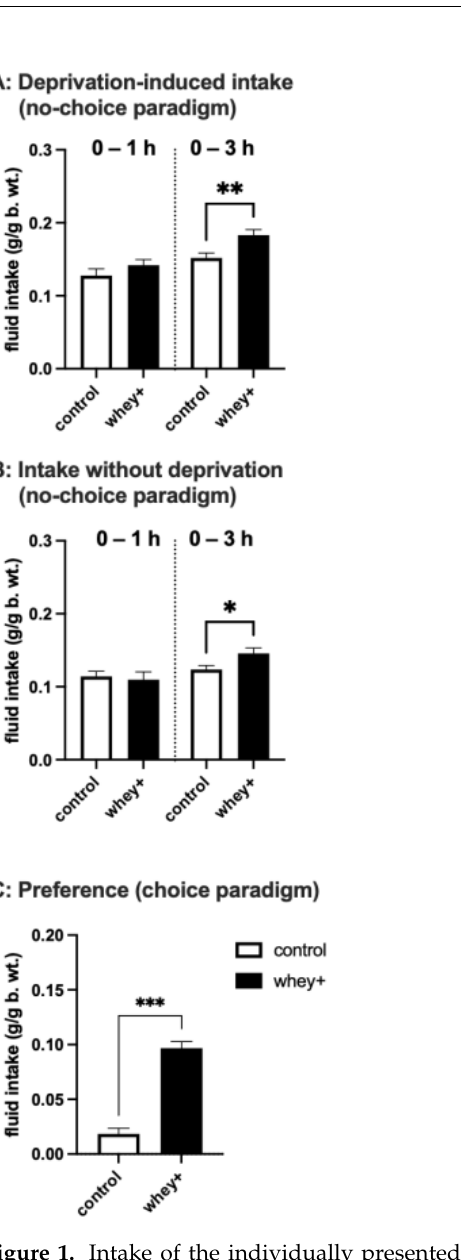
Figure 1. Intake of the individually presented natural Control (20:80 whey:casein) CM and the whey-adapted (60:40 whey:casein; whey+) CM in ( A ) overnight-deprived mice and ( B ) non-deprived mice during 3-h access to the diets. Intake was measured at 1 and 3 h. ( C ) Intake of simulta- neously presented Control (20:80) CM and whey-adapted (60:40) CM during a 2-h two-bottle choice test. * p ≤ 0.05; ** p ≤ 0.01; *** p ≤ 0.001.